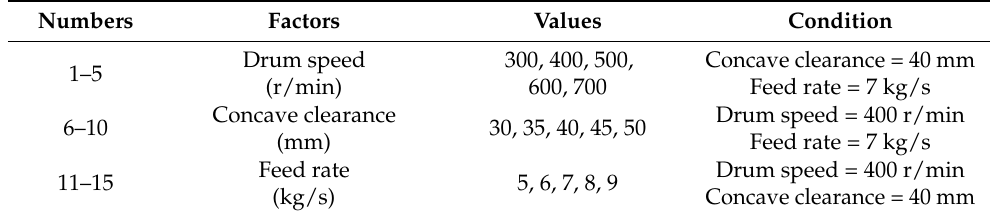
Table 1. Experimental scheme design of single factor.